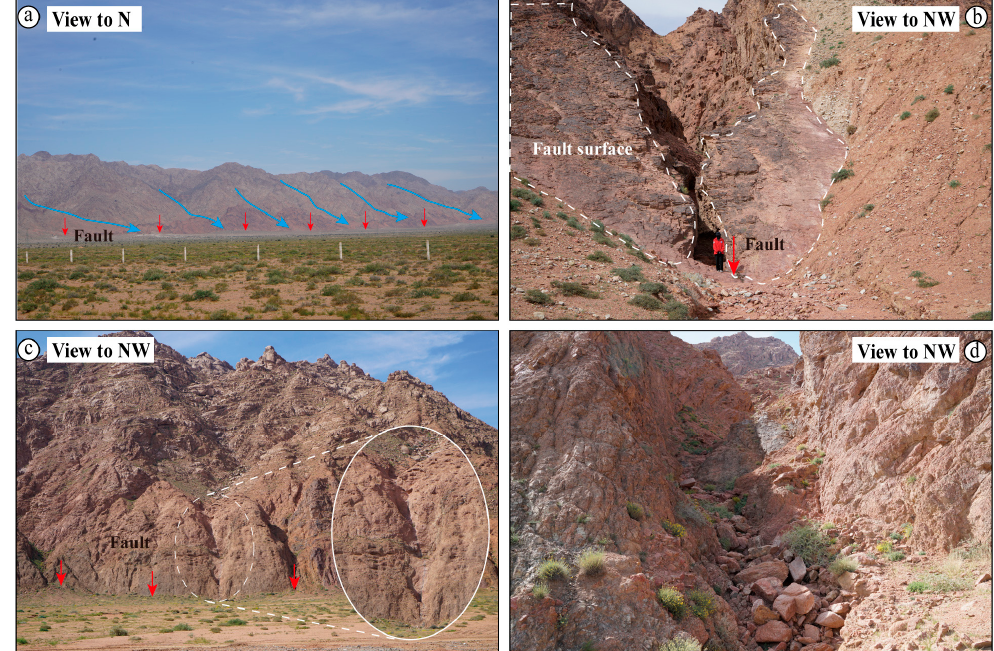
Figure 8. ( a – d ) : Photographs of the bedrock channel morphology in Yabrai Shan. The blue lines in ( a ), white dashed in ( b ) and white circle in ( c ) show the river direction, fault surface and a close view of a channel, respectively. The red arrows indicate the fault.